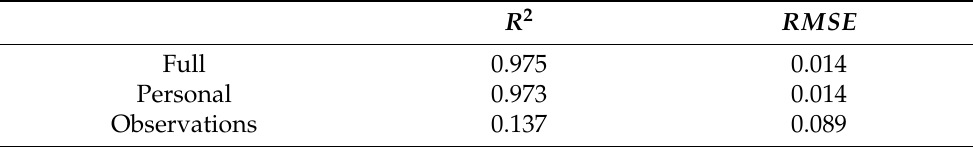
Table 3. Comparison of fitted